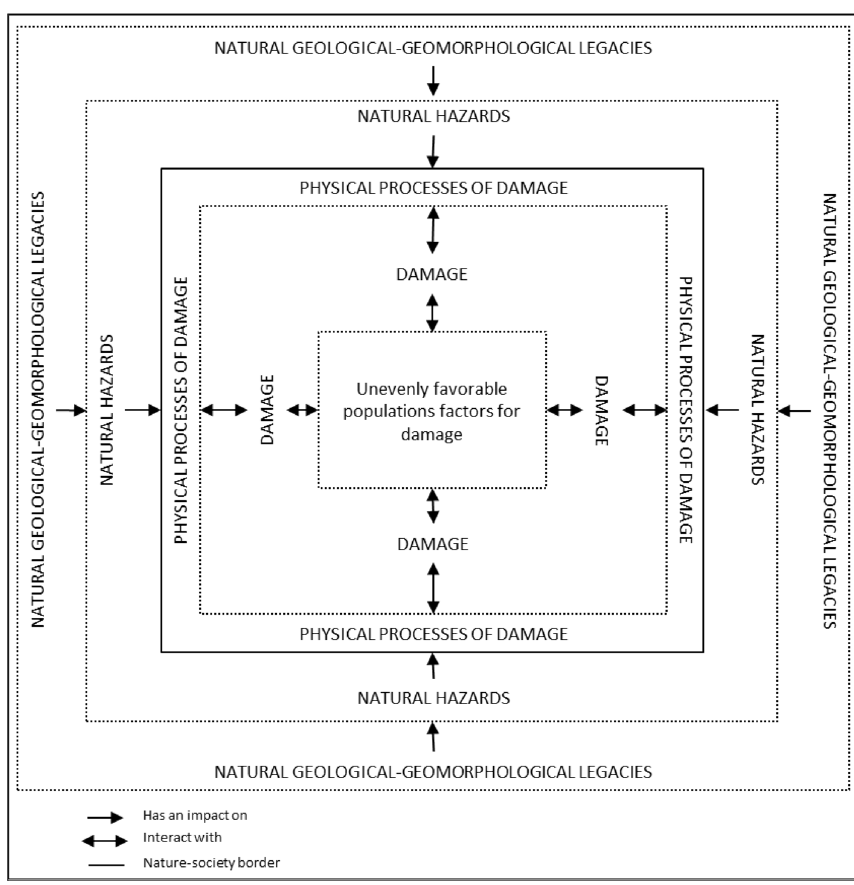
Fig. 12 Evolving conceptual model. Source Adapted from Pigeon